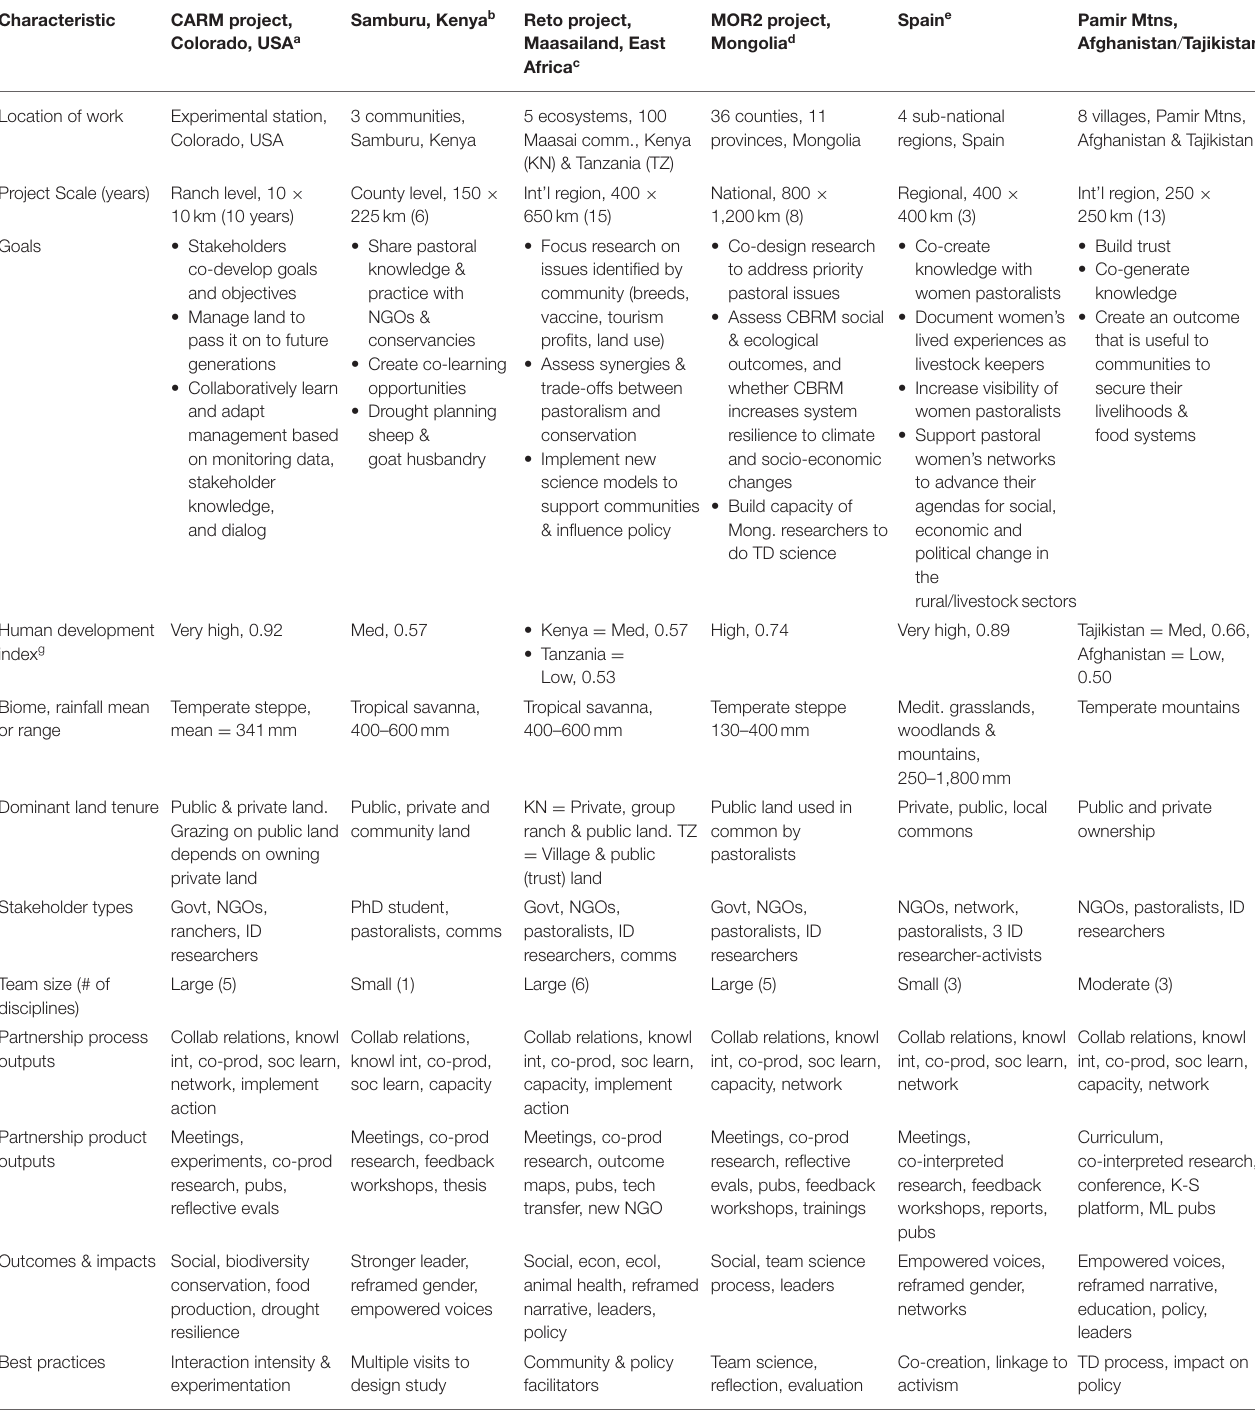
TABLE 1 | Selected characteristics of six rangeland partnering case studies in North America, Europe, Africa, & Asia.